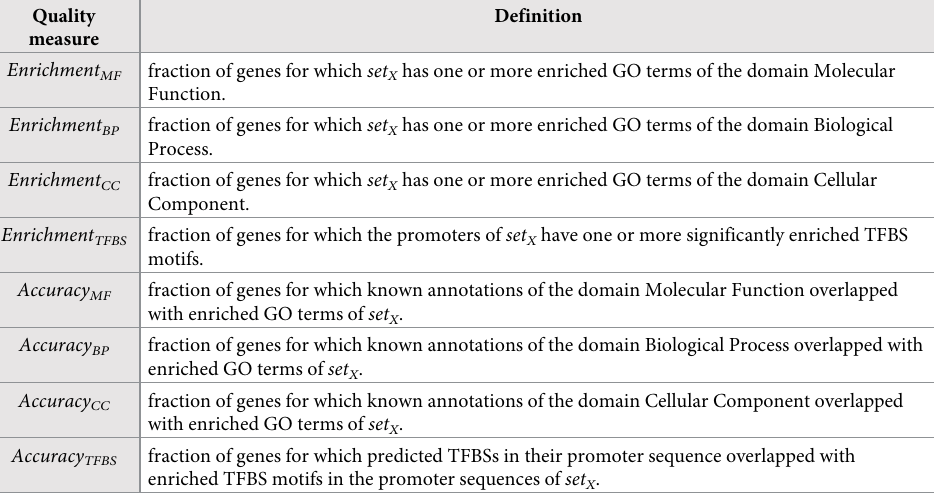
Table 1. Overview of the eight quality measures used to define the quality of genome-wide gene co-expression networks.